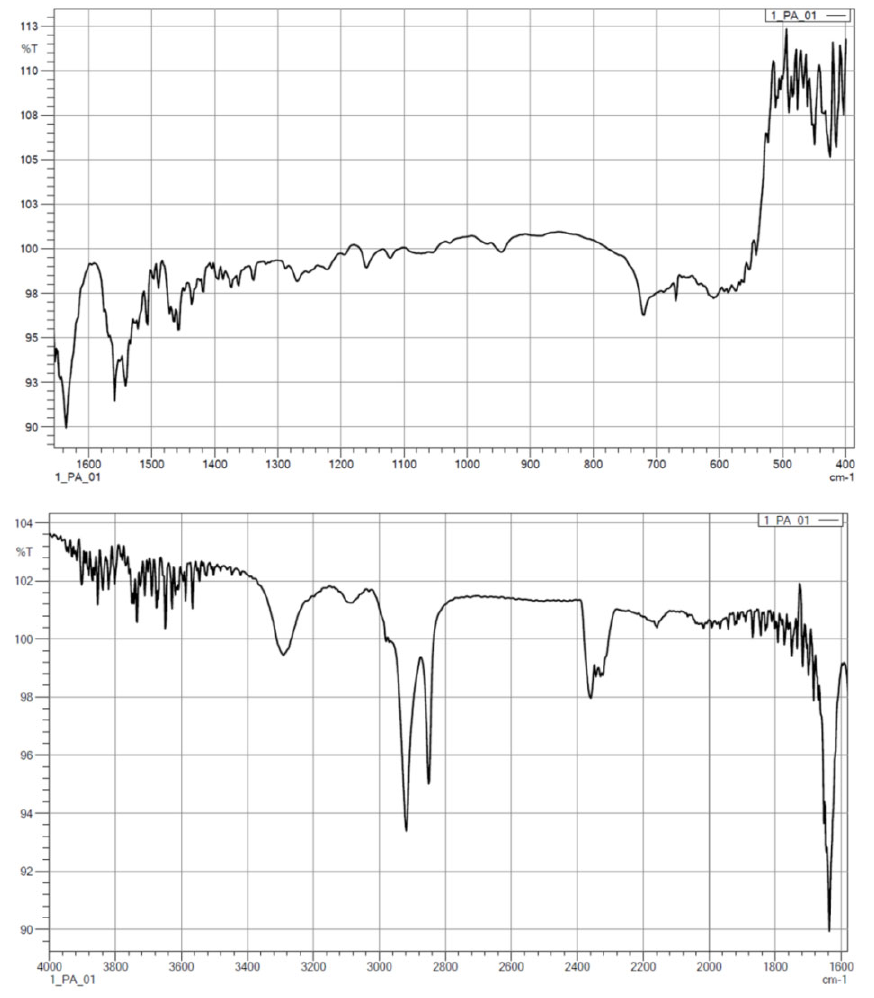
Figure 7. IR spectra for pure PA-12 after artificial ageing.